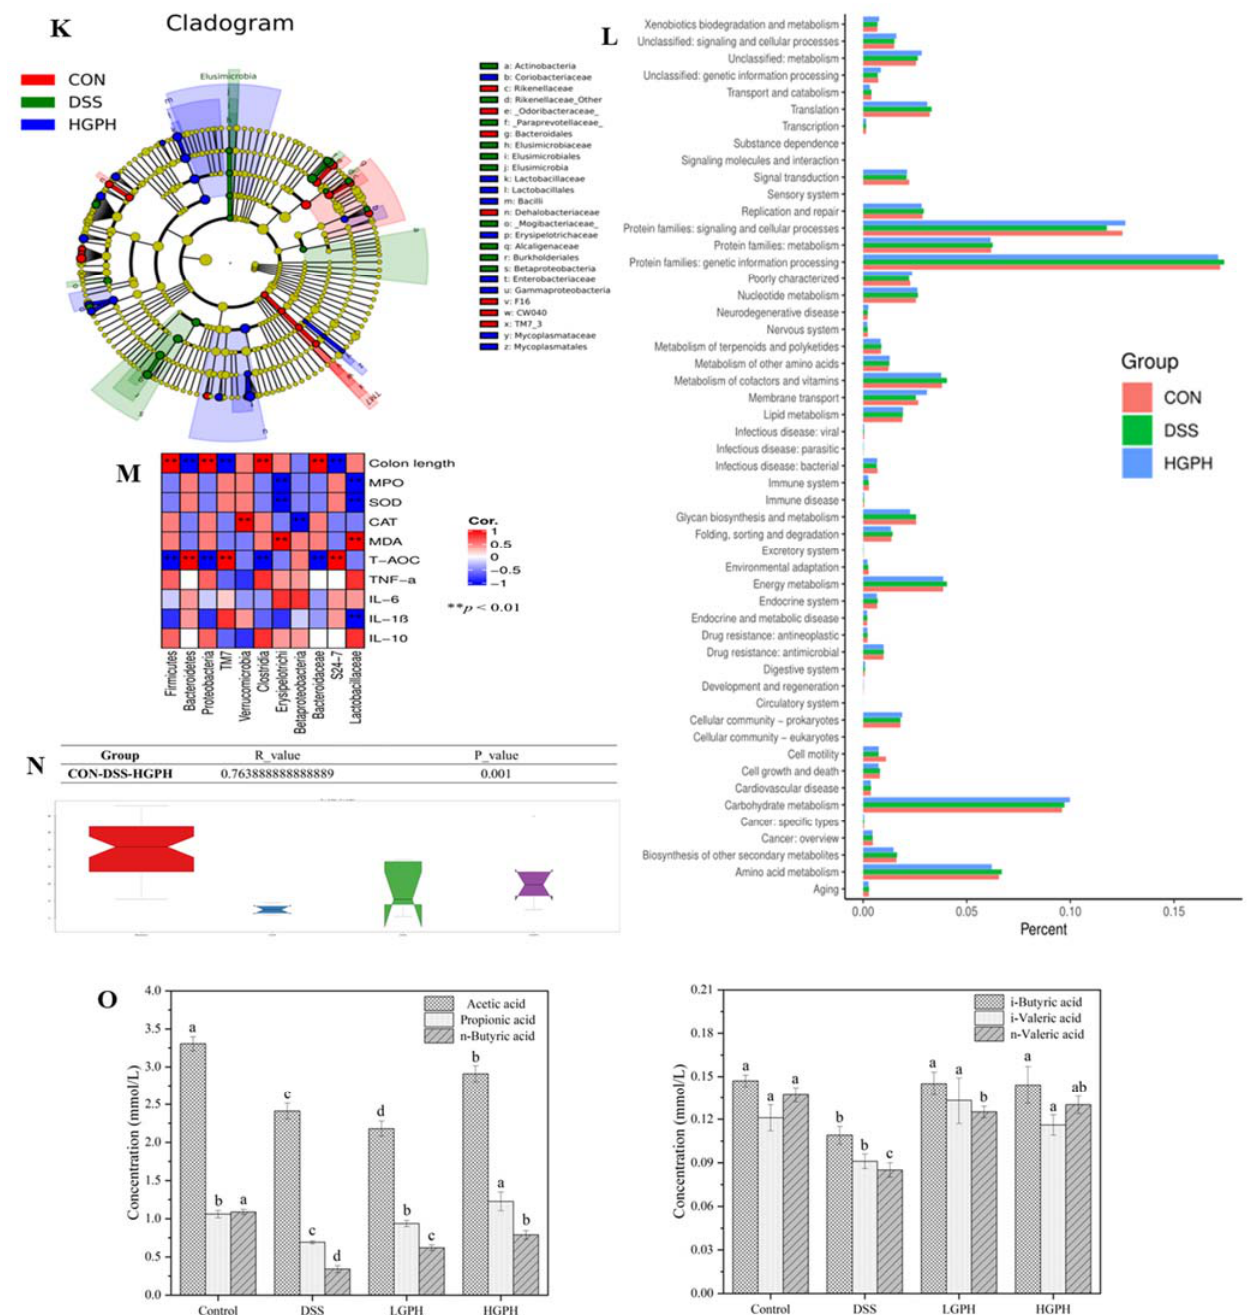
Figure 5. GPH extracts altered gut microbiota in mice with DSS-induced colitis. Gut microbiota composition at the phylum level ( A ) and family level ( B ); different groups of differential microbial taxa at the phylum level ( C , D ) and family level ( F – J ); the ratio of Firmicutes/Bacteroidetes (F/B) at the phylum level ( E ); taxonomic cladogram obtained from LEfSe analysis of 16S sequences ( K ); KEGG pathway analysis ( L ); Spearman’s rank correlation coefficients ( M ); ANOSIM analysis ( N ); SCFAs content ( O ). Values not sharing a common superscript letter denote significant difference ( p < 0.05).